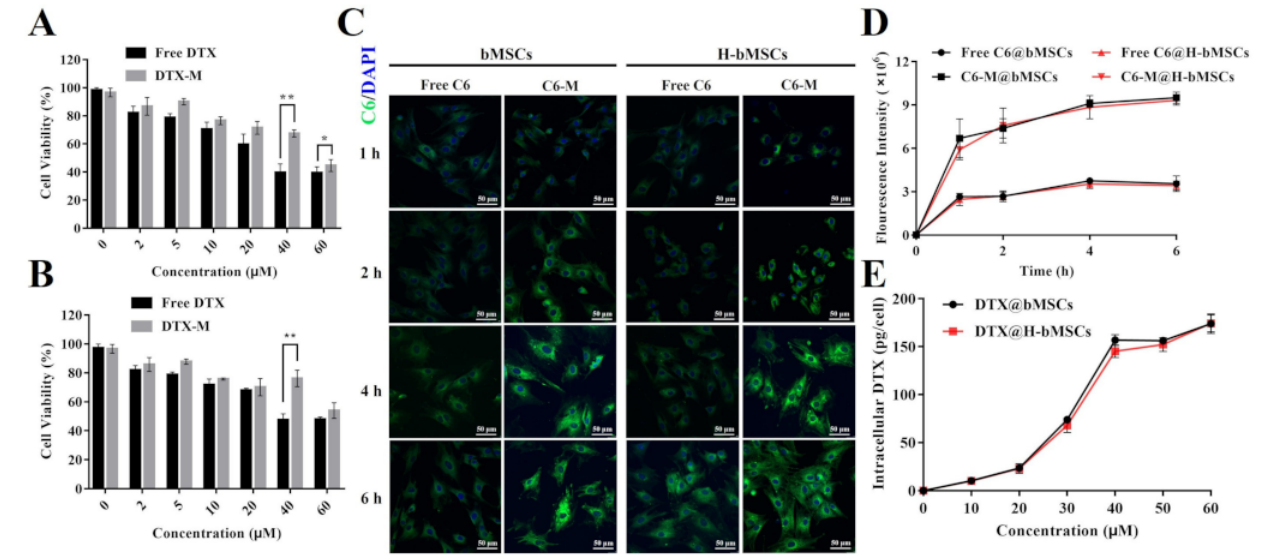
Figure 3. Construction of DTX@H-bMSCs and DTX@bMSCs. The cytotoxicity of DTX-M or free DTX to bMSCs ( A ) and H-bMSCs ( B ), respectively. The fluorescence images ( C ) and the quantification ( D ) of C6 or C6-M uptake by H-bMSCs and bMSCs with different incubation times. The drug loading detection of DTX@H-bMSCs and DTX@bMSCs with different DTX-M concentrations ( E ). (* p < 0.05) (** p <